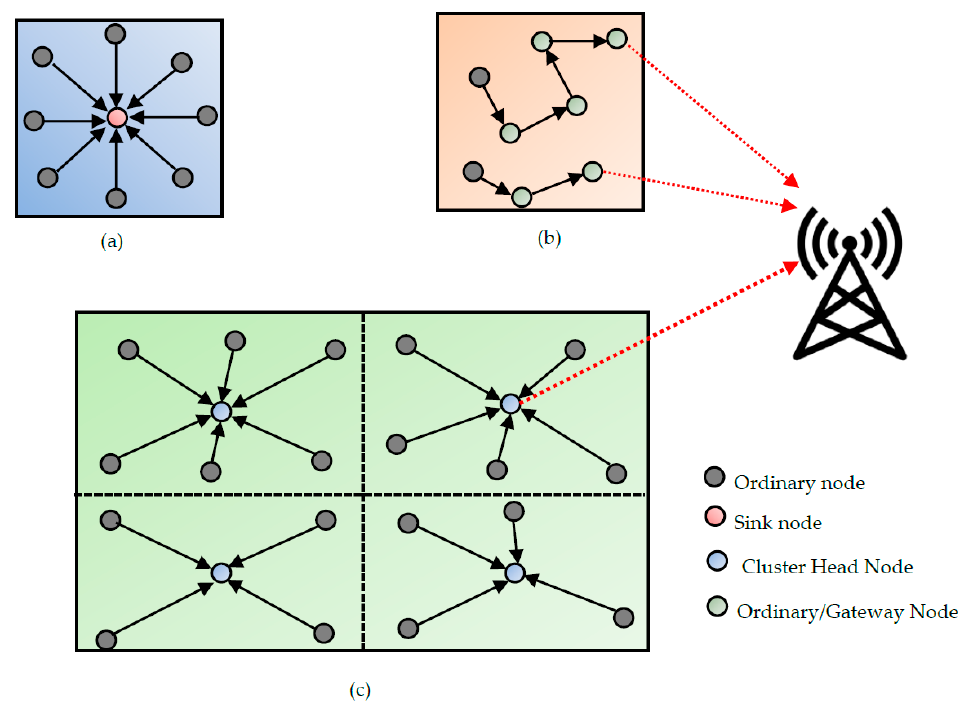
Figure 19. Main network topologies. ( a ) Star, ( b ) Mesh, ( c ) Cluster.